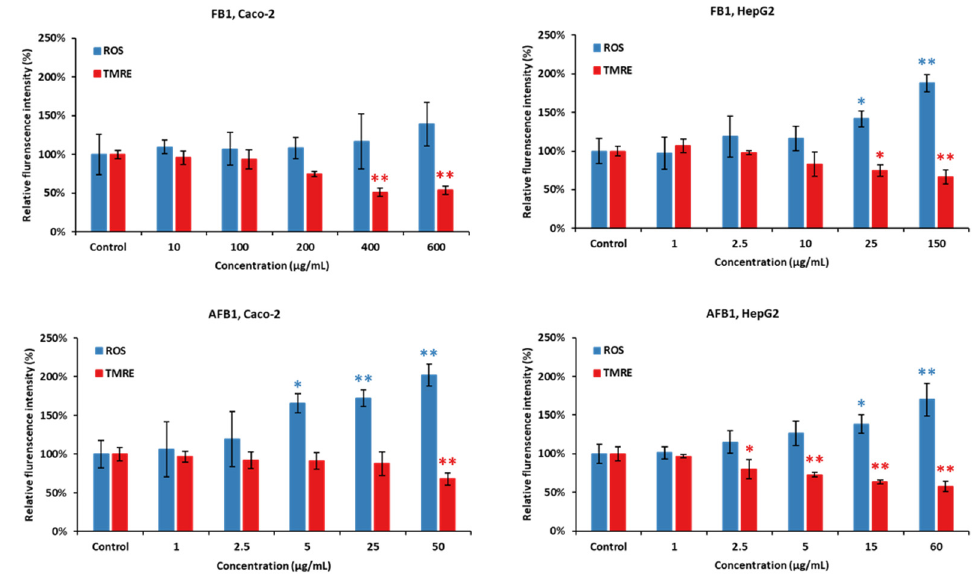
Figure 7. Effect of FB1 and AFB1 on reactive oxygen species (ROS) production and mitochondrial membrane permeability (MMP) in Caco-2 and HepG2 cells after 24 h exposure. Data (at least three technical replicates) are expressed as mean ± standard deviation. Statistic difference at equivalent toxicity is labeled by **: p < 0.01; *: p < 0.05 versus control by one-way ANOVA with Dunnett’s post hoc test.